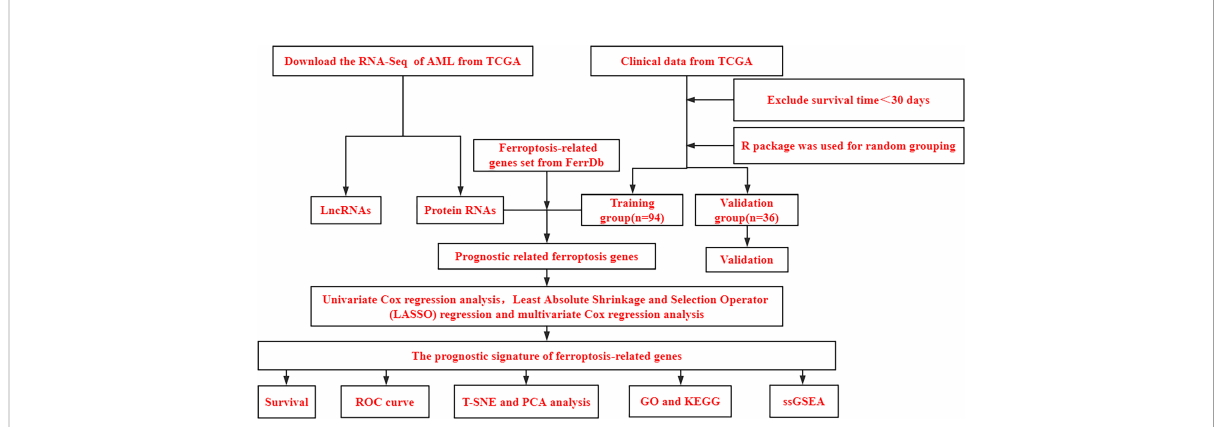
FIGURE 1 Bioinformatics Analysis Flowchart. TCGA, The Cancer Genome Atlas database; AML, Acute myeloid leukemia; PCA, principal component analysis; t-SNE, t -distributed stochastic neighbor embedding; GO, Gene Ontology; KEGG, Kyoto Encyclopedia of Genes and Genomes; ssGSEA, single-sample gene set enrichment